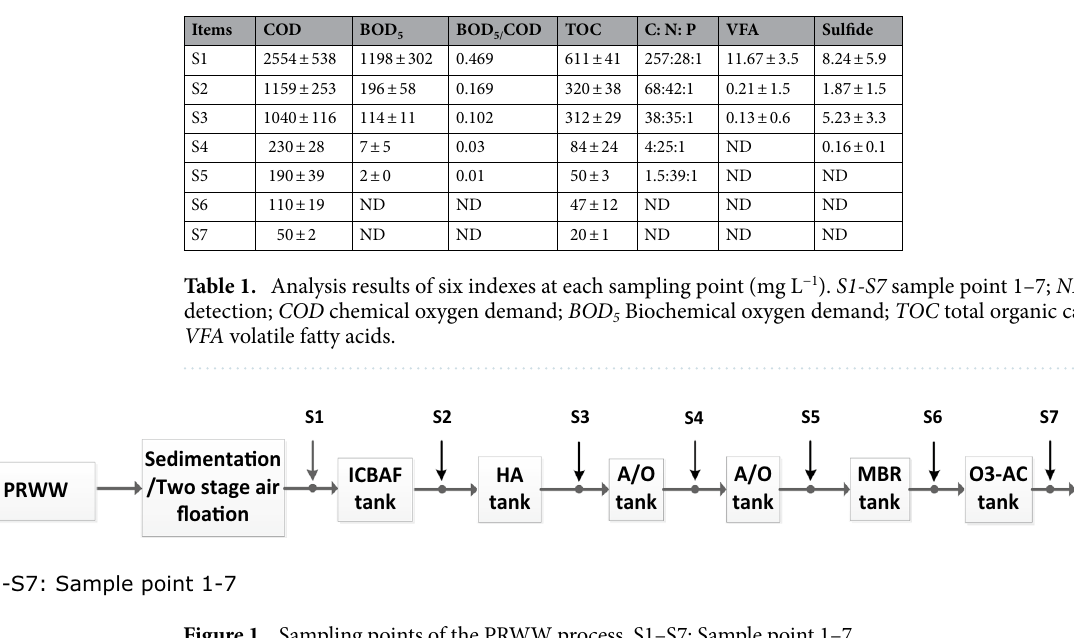
Figure 1. Sampling points of the PRWW process. S1–S7: Sample point